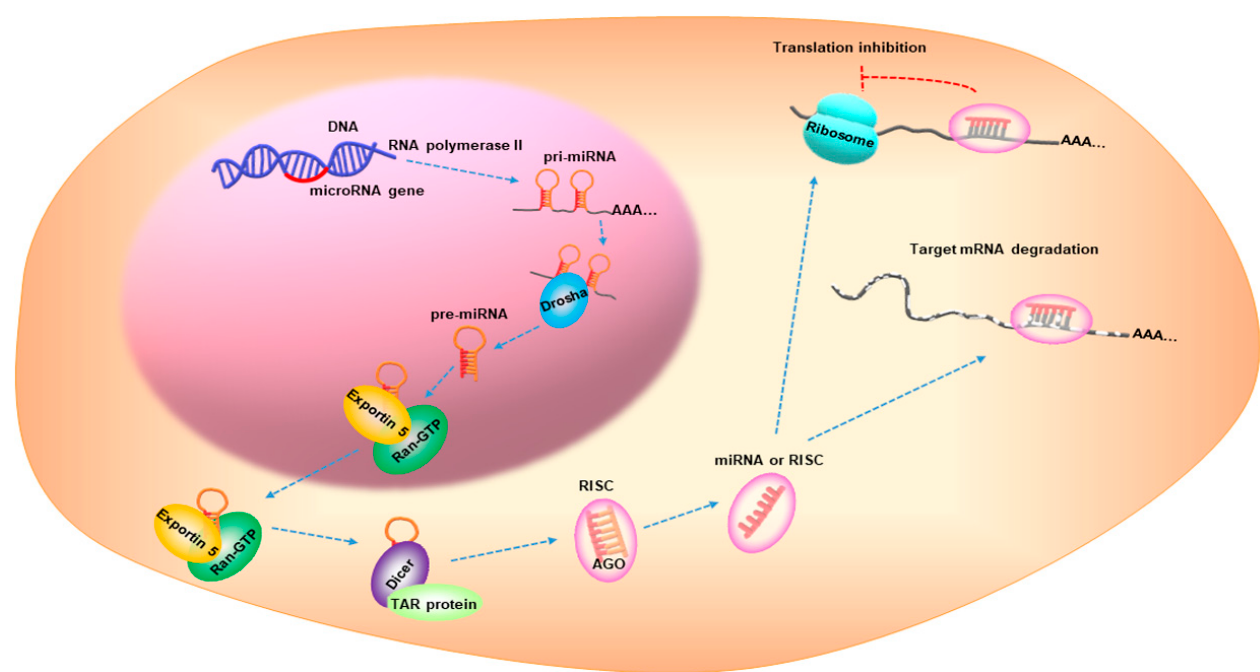
Figure 2. microRNA biogenesis. AGO, Argonaute; RISC, RNA-induced silencing complex.